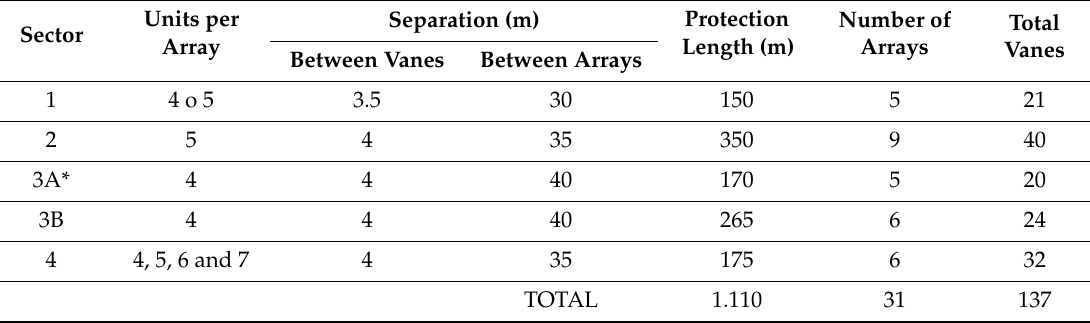
Figure 26. Ariari River, PR68: hydraulic modeling results with BVANE for different combinations of elements for the protective design, in a representative section. Seven months after the design was completed, beginning 4 May 2018, the C3 to C8 arrays were installed, in order, followed by the C1 to C3 assemblies. At this point, unfortunately, the rainy period intensified in the region, the intensities and durations of which generated increasingly frequent, large water flows and high transports of solids and vegetal materials. Thus, a wide isle of sediment was developed in the center of the channel, upstream of the arrays already installed. Fractionation of flows in the sector directed them from the right arm to the left bank, thus exacerbating the erosion of